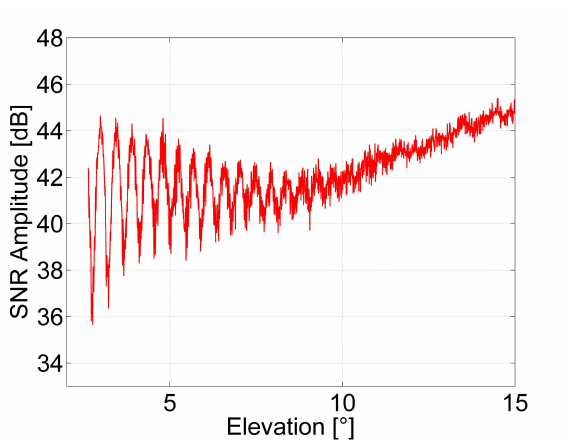
Figure 9: Example of SNR data from GPS satellite 1 for elevation between 2° and